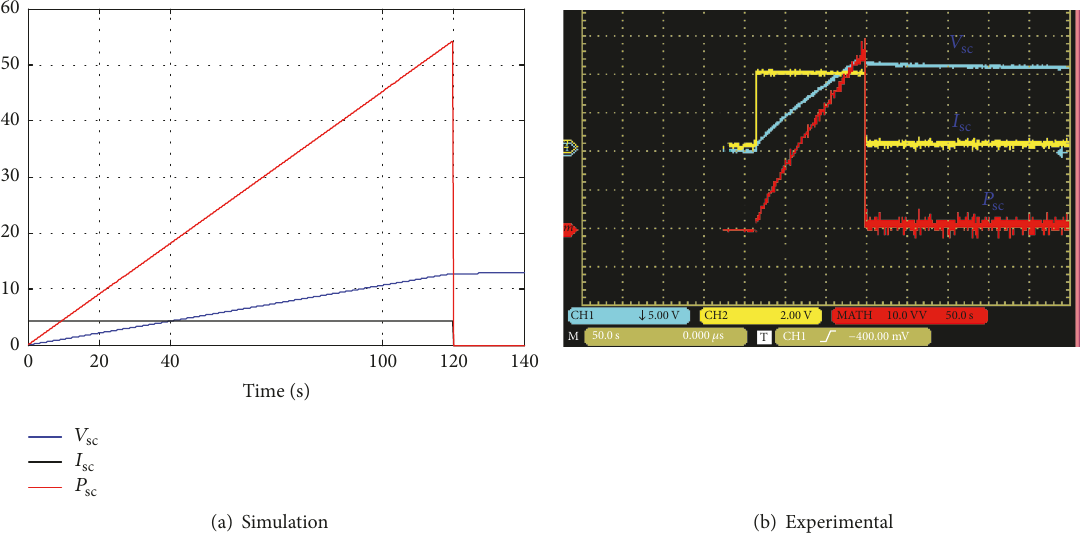
Figure 13: Voltage, current, and power waveforms of the ultracapacitors (charging mode-parallel).